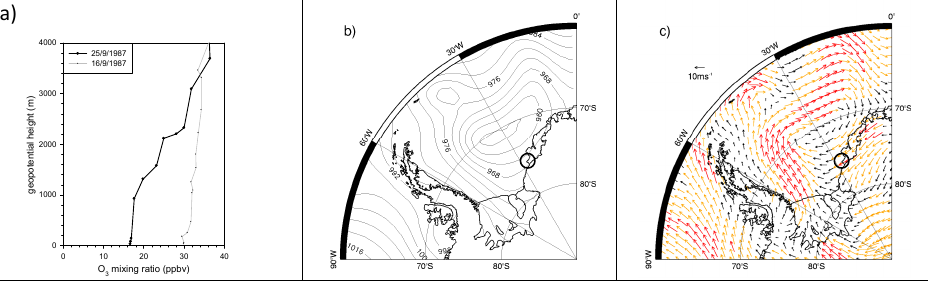
Fig. 13. (a) Ozonesonde measurements on 25 September 1987 compared with an un-depleted profile for the middle of the same month; (b) mean sea level pressure on 24 September 1987 (noon); (c) 10-m wind vectors on 24 September 1987 (noon) – wind speeds identified as: black = < 8ms − 1 ; orange = 8 to 12ms − 1 ; red = > 12ms − 1 . Halley is marked by the black circle on the plots.